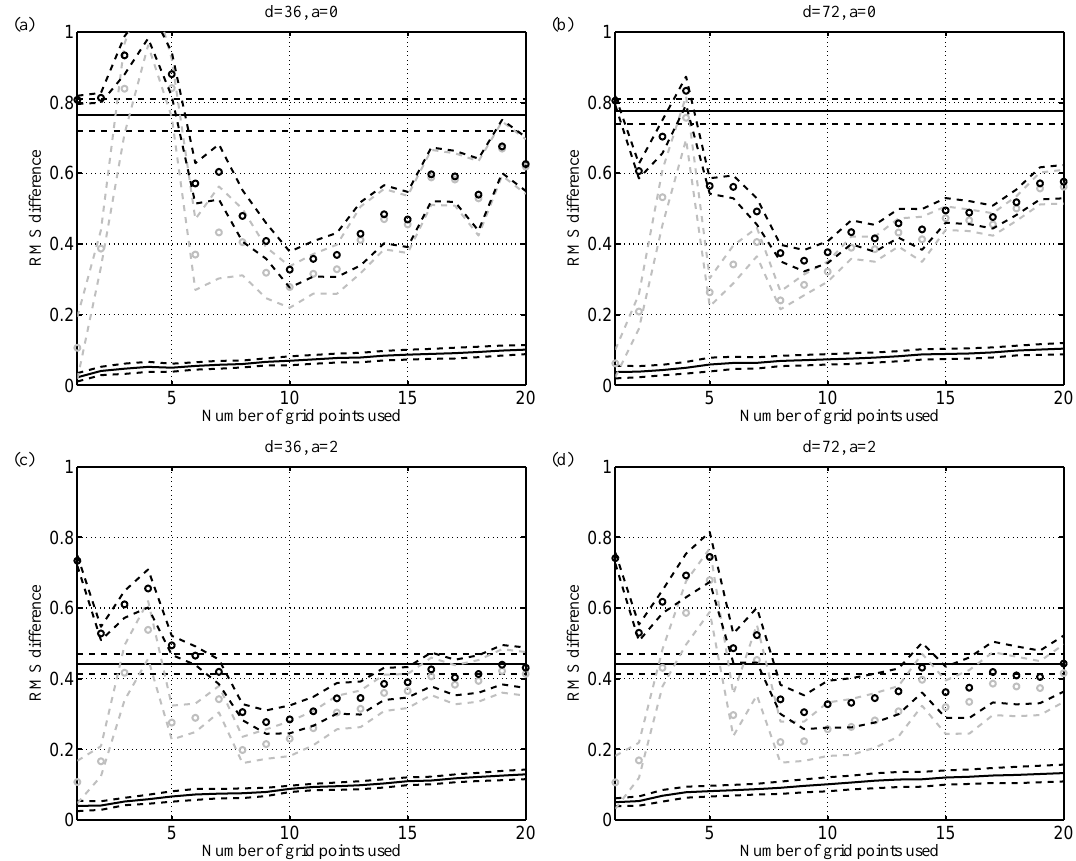
Fig. 4. RMS difference between the response of the Lorenz 95 system estimated by integrating (3) and using the non-parametric FDT (A1) where the number of elements in the full state vector for (a) and (c) is d = 36 and for (b) and (d) is d = 72. Plots (a) and (b) correspond to the deterministic system with a = 0 and plots (c) and (d) correspond to the same system with additional stochastic noise, a = 2. The black circles indicate the RMS difference of the entire state vector using (8) and (9). The grey circles indicate the RMS difference of only the elements to which the calculation is applied using (8). The solid line at the bottom of each plot indicates the minimum possible RMS difference of the grey circles with this data set, i.e. the difference between the responses estimated using two independent sets of data found by integrating (3). The straight horizontal line is the RMS difference between integrating (3) and the response estimated using the Gaussian form of the FDT (2) for the 36-element system; see Fig. (5) for a plot of this response. The dashed lines, indicating uncertainty, represent two standard deviations divided by the square root of the number of independent integrations. An estimate with zero skill, (given by (9) with the entire state vector being independent of the forcing), has a RMS difference of one using this normalisation. It is possible to do worse than this by overestimating the response by a factor of greater than 2.